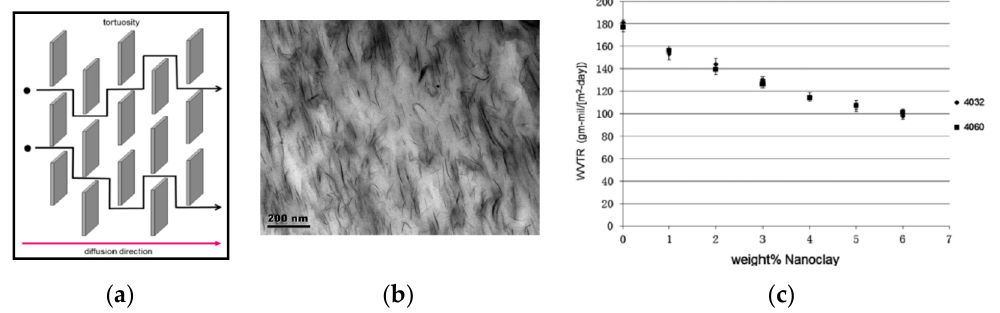
Figure 7. ( a ) Schematic representation of the “tortuous path” model for nanocomposites. ( b ) Transmission electron micrograph (TEM) of PLA nanocomposite containing 3 wt.% of montmorillonite, showing aligned clay platelets. ( c ) Water vapor transmission rates (WVTR) of PLA nanocomposites as a function of wt. nanofillers for two different PLA grades [41], Reproduced with permission from Duan Z, J. Membrane Sci.; published by Elsevier,